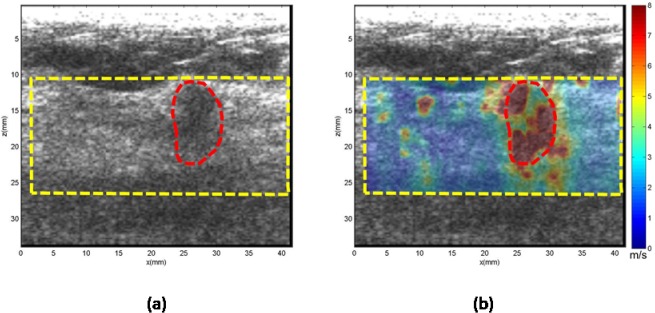
US and CUSE shear wave speed map of breast tissue (dashed yellow contour) including the breast mass ROI (red dashed contour).(a) B-mode US image. (b) CUSE shear wave speed map.